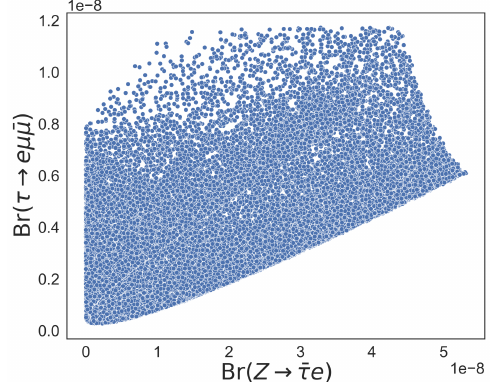
Figure 9 . Scatter plot Br( Z → ¯ τe ) vs. Br( τ → ee ¯ e ) .